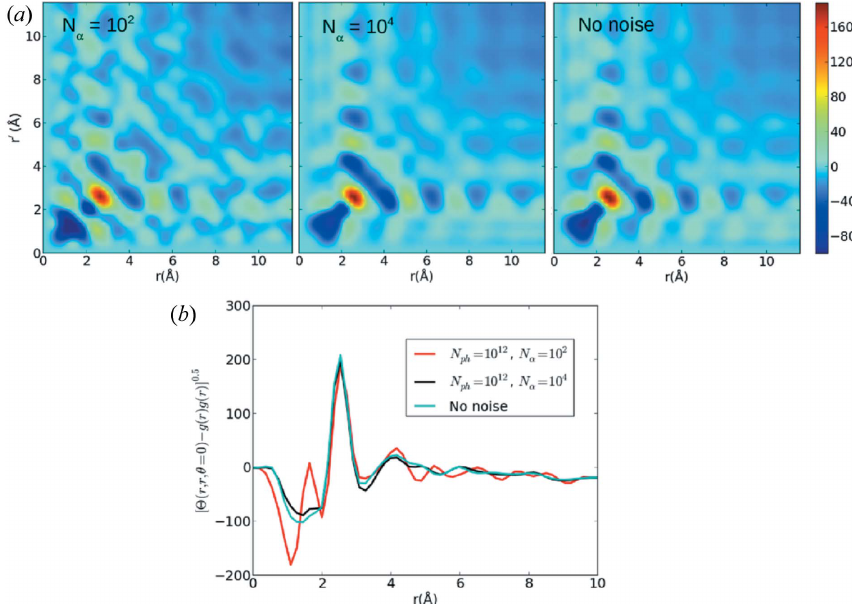
Figure 6 ( a ) The effect of noise on (cid:2) ð r ; r 0 ;(cid:2) ¼ 0 Þ for amorphous nickel varying the number of patterns. The centrosymmetric filter has been applied to the intensity correlations. For N ¼ 10 4 agrees well with the noise-free simulation. b The r ¼ r 0 diagonal in the reconstruction, but N (cid:3) ¼ 10 2 agrees with the noise-free simulation at the first-nearest-neighbour peak shows that N (cid:3) (2.5 A˚ ), but disagrees elsewhere.